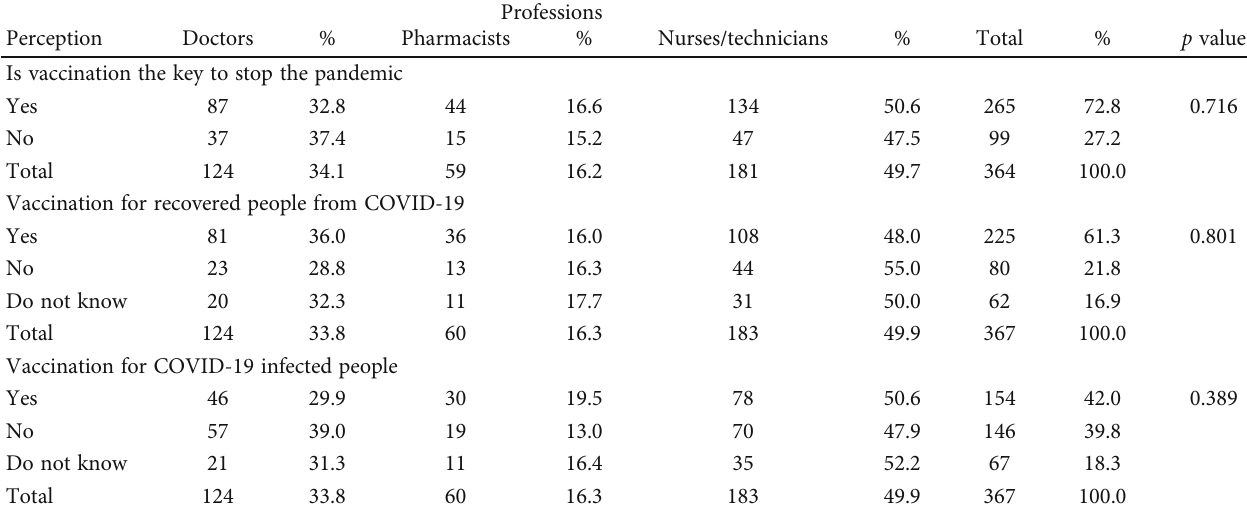
Table 3: Assessment of perception of participants about COVID-19 vaccination based on their